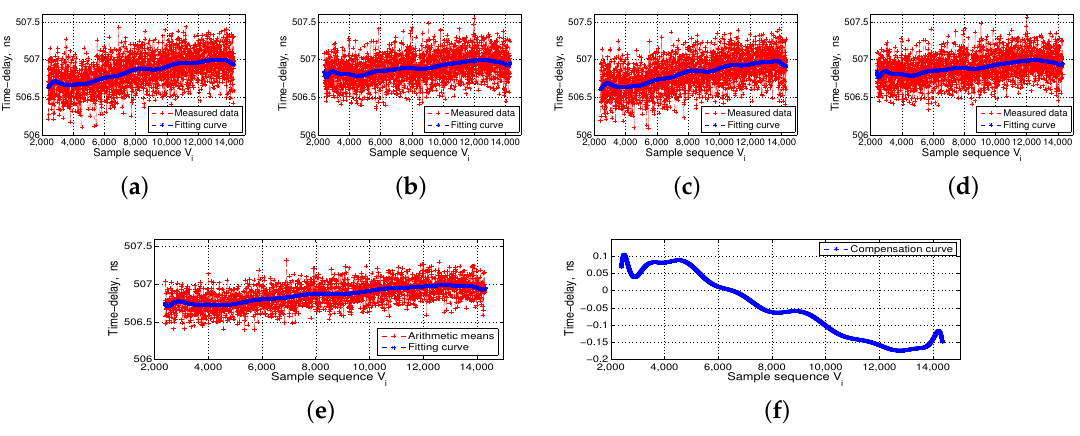
Figure 8. Digital baseband (DBD) reception-delay measurement data preprocessing. ( a – d ) the reception-delay data measured four times and the corresponding fitting curves; ( e ) the arithmetic means of the delay data measured four times and the corresponding fitting curves; and ( f ) the final reception-delay compensation curves of the